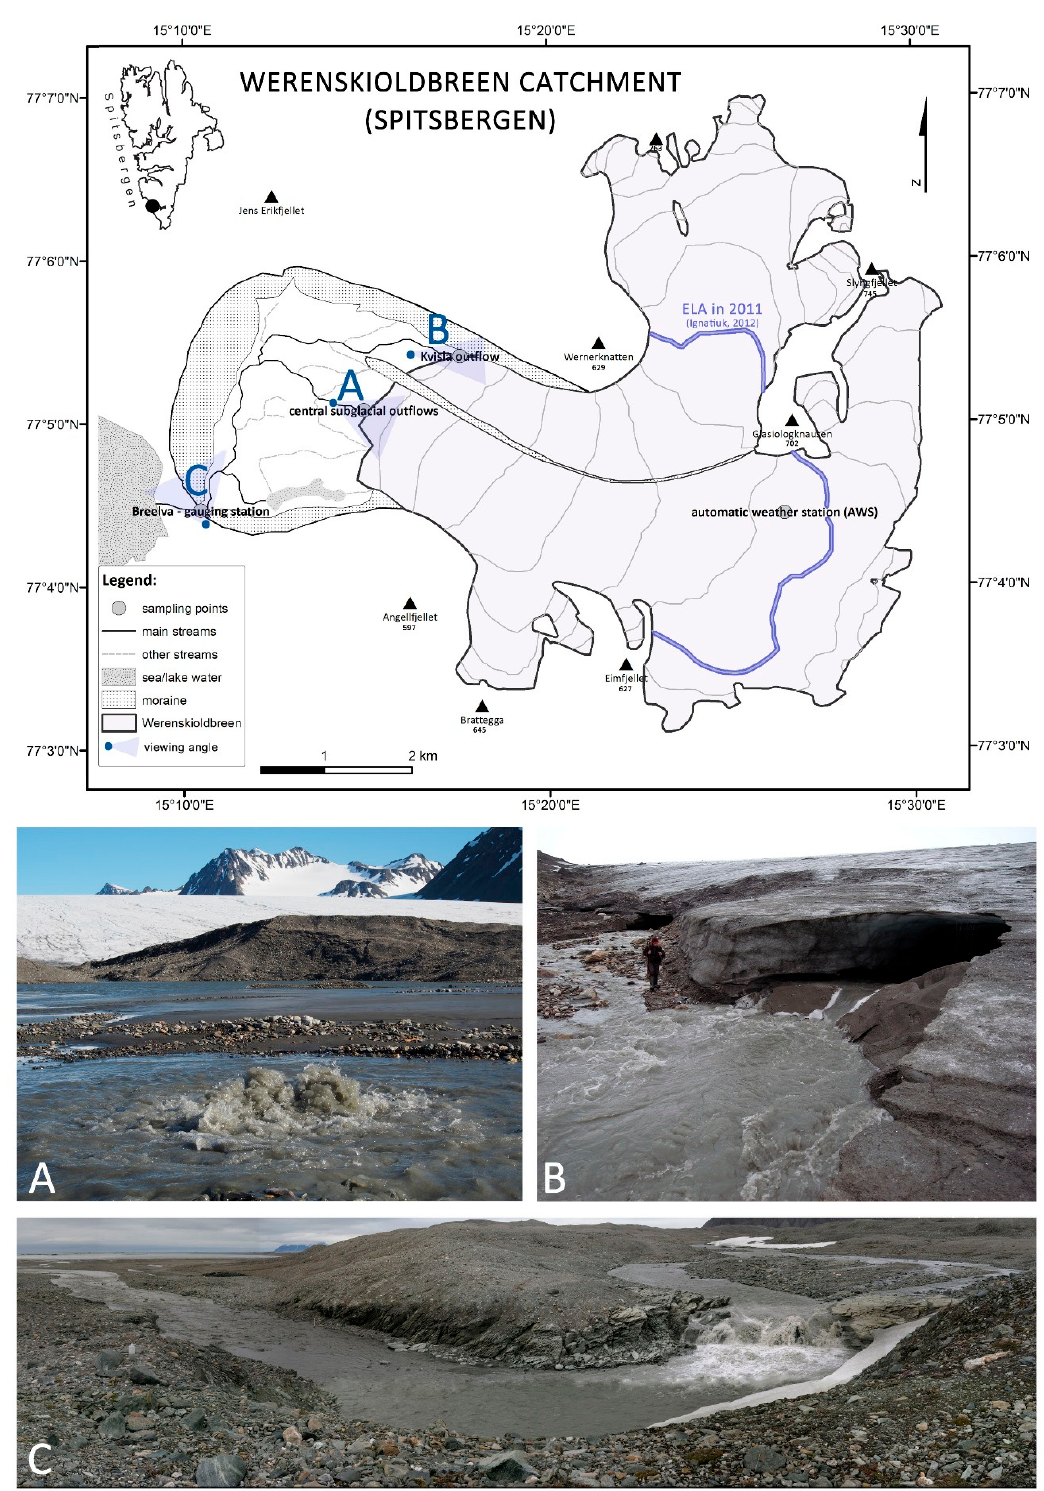
Figure 1. Measurement points in the Werenskioldbreen catchment: ( A ) subartesian central subglacial outflows, ( B ) the Kvisla channelized outflow (R-channel), ( C ) Breelva gauging station (E. Łepkowska and P. Ł epkowski).